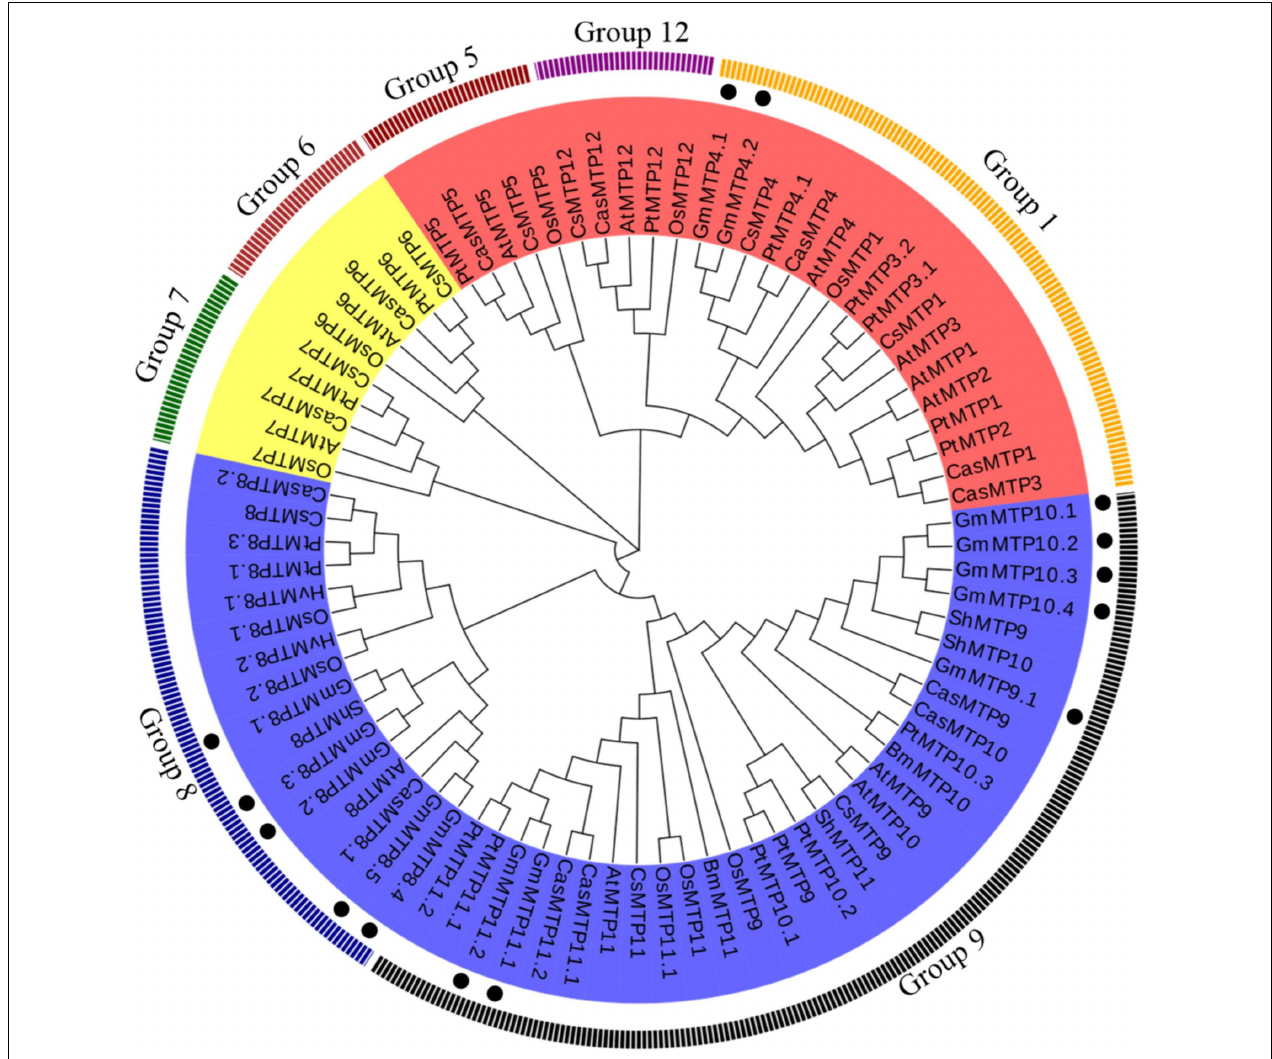
FIGURE 3 | Phylogenetic analysis of metal tolerance proteins (MTPs) in soybean and other plants. The phylogenetic tree was constructed using the MEGA4.1 program. Except for CasMTPs derived from tea plant ( Camellia sinensis ), the first two letters of each protein represent the abbreviated species name. At: Arabidopsis thaliana , Os: Oryza sativa , Gm: Glycine max , Cs: Cucumis sativus , Hv: Hordeum vulgare , Pt: Populus trichocarpa , Sh: Stylosanthes hamata , and Bm: Beta vulgaris . ssp. maritima . MTPs from various plant species are divided into the Zn-CDF, Fe/Zn-CDF, and Mn-CDF clusters, which are highlighted in red, yellow, and blue, respectively. Plant MTPs can be further classified into seven subgroups. The solid circles indicate MTPs from